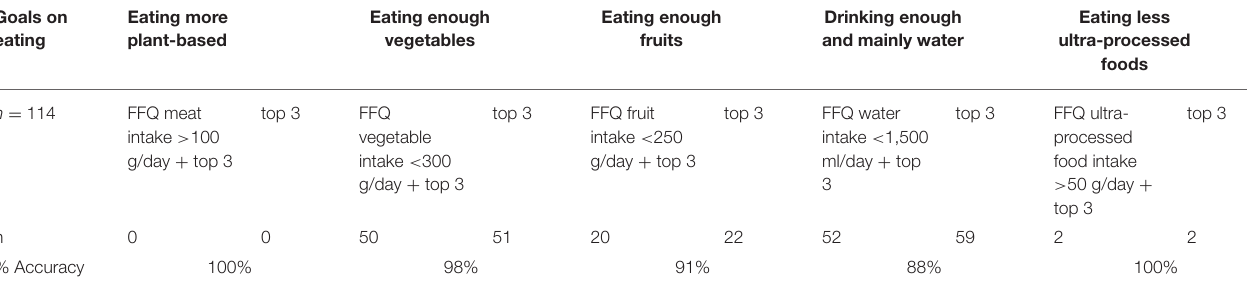
TABLE 4 | Accuracy of correctly assigning food literacy goals on eating to participants’ needs. Goals on